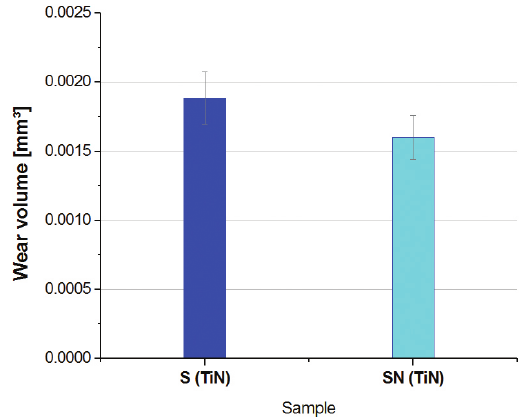
Figure 4. Average volume loss of TiN after ball on disc tests for the S(TiN) and